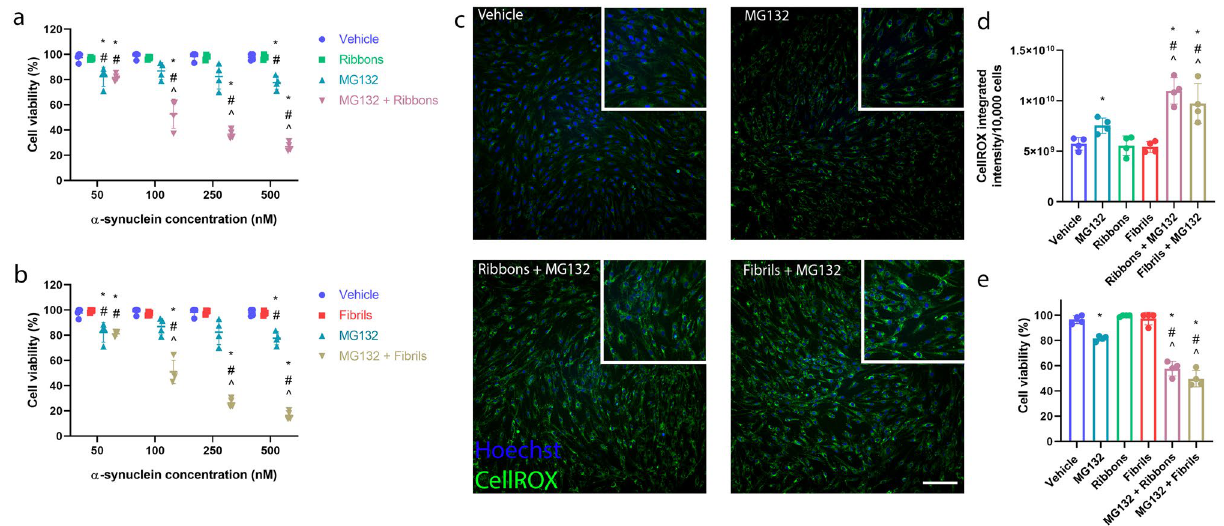
Figure 8. Primary human brain pericytes response to α-syn pre-treated with MG132. Cell viability of primary human brain pericytes when pre-treated with MG132 (5 µM) for 6 h prior to the incubation with either ( a ) ribbons (50–500 nM) or ( b ) fibrils (50–500 nM) for 24 h . ( n = 4 epilepsy cases, mean ± SD). * p < 0.05 compared to vehicle, # p < 0.05 compared to either ribbons or fibrils in the respective graph, ^ p < 0.05 compared to MG132 treatment alone; two way ANOVA with Tukey’s multiple comparisons test. ( c ) Representative immunocytochemistry images of the ROS production using cellROX in primary human brain pericytes after treatment with vehicle, MG132, MG132 and ribbons and MG132 and fibrils. Scale bar = 50 µm. ( d ) Graphs showing the amount of ROS produced using cellROX integrated intensity when normalized to 10,000 cells when pre-treated with 5 µM MG132 for 6 h prior to co-incubation with either ribbons (100 nM) or fibrils (100 nM) for 24 h. ( n = 4 epilepsy cases, mean ± SD). ( e ) Graphs showing cell viability of primary human brain pericytes when pre-treated with 5 µM MG132 for 6 h prior to co-incubation with either ribbons (100 nM) or fibrils (100 nM) for 24 h . * p < 0.05 compared to vehicle, # p < 0.05 compared to MG132 treatment, ^ p < 0.05 compared to ribbons or fibrils in the respective graph, + p < 0.05 compared to MG132 or ribbons and fibrils treatment in the respective graph; one way ANOVA with Tukey’s multiple comparisons